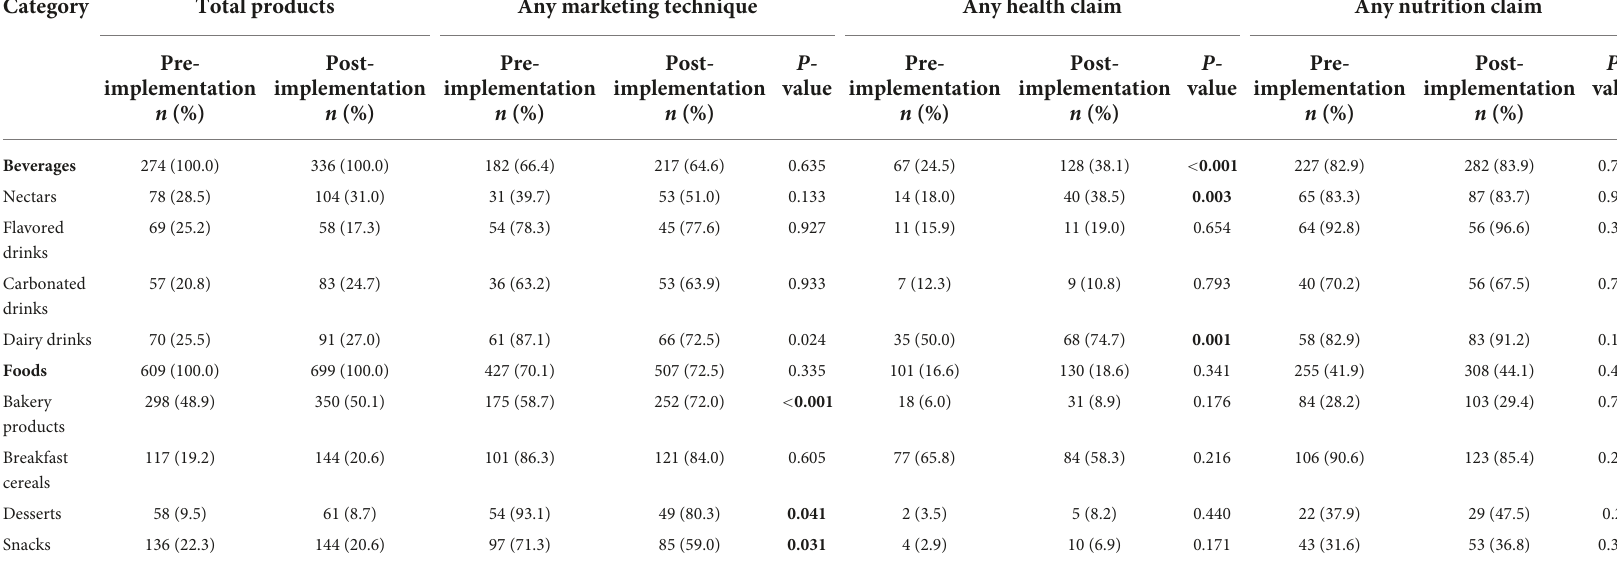
TABLE 2 Marketing techniques, health, and nutritional claims before and after front-of-package warning labels policy implementation, cross sectional